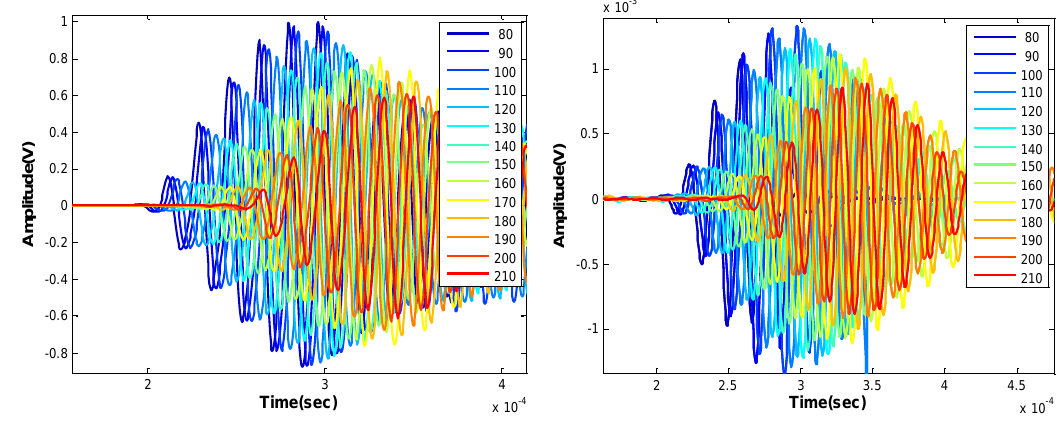
Figure 15. Ultrasonic surface wave time signals collected with sensor aligned along wave path on concrete; contact accelerometer ( left ) and with noncontact MEMS ( right